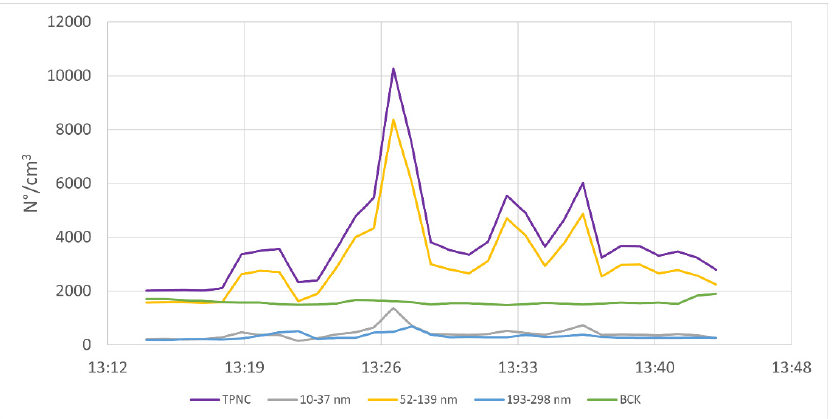
Figure 4. TPNC trends and the main particle size classes for O3–removing and cleaning of the final product and the recovering of unused powder with an external specific vacuum cleaner.